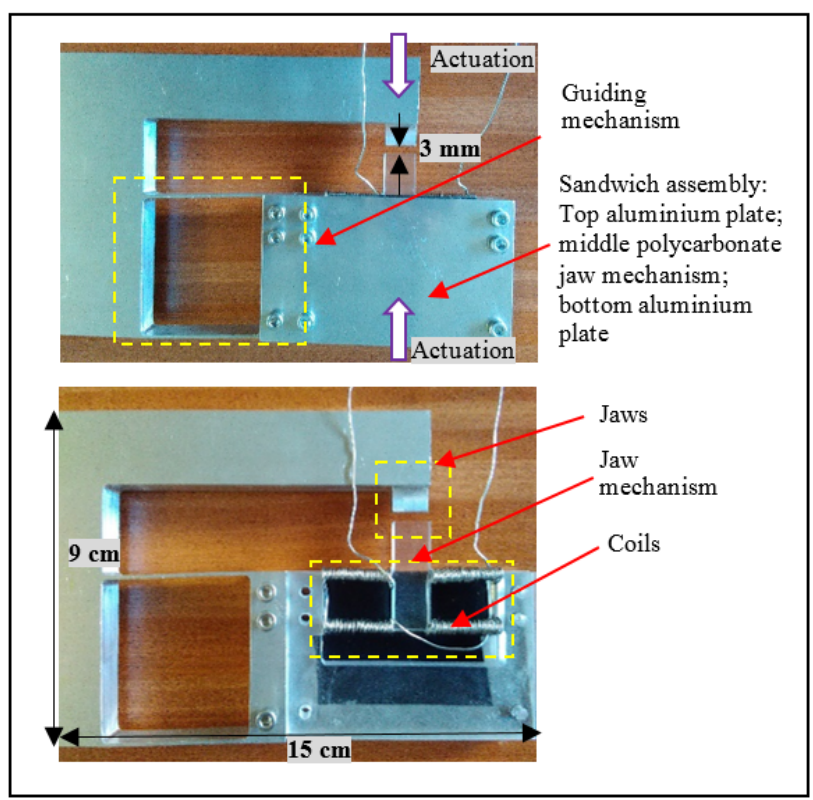
Figure 2. Fully assembled asymmetrical gripper shown next to a hand for reference ( above ); top plate removed, revealing the heating coil ( below ).